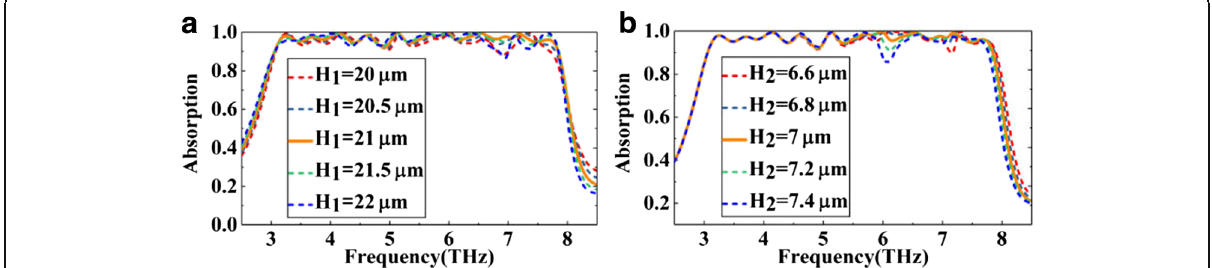
Fig. 9 The simulated absorption spectra of the proposed absorber with different thickness of the dielectric layer and with different thickness of the SiO 2 layer corresponding to a and